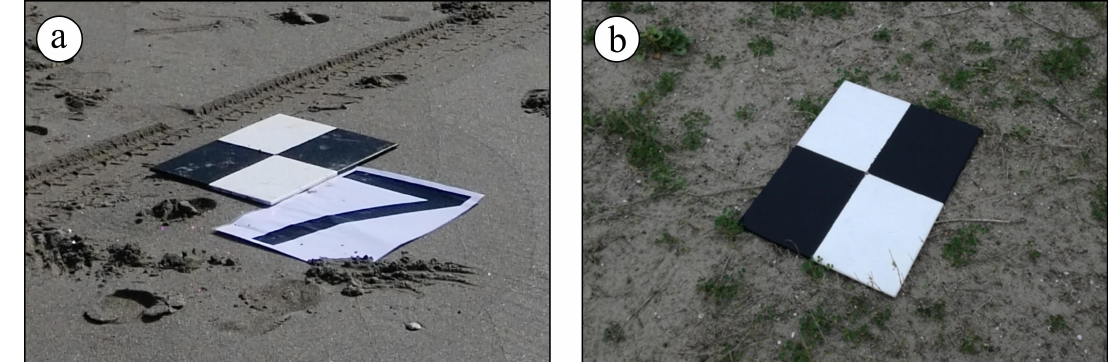
Figure 6. Targets used as Ground Control Points to be recognized on the aerial images placed ( a ) on the shoreline (initially numbered to be used for the processing of the Panasonic Lumix DMC–GM images) and ( b ) on the back-dunes (not numbered thanks to the Exif metadata in the DJI FC300X